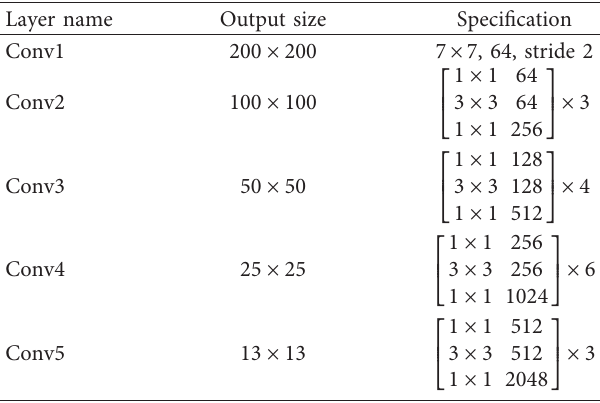
Table 1: Architecture of FTSD-IEFSSD with ResNet50